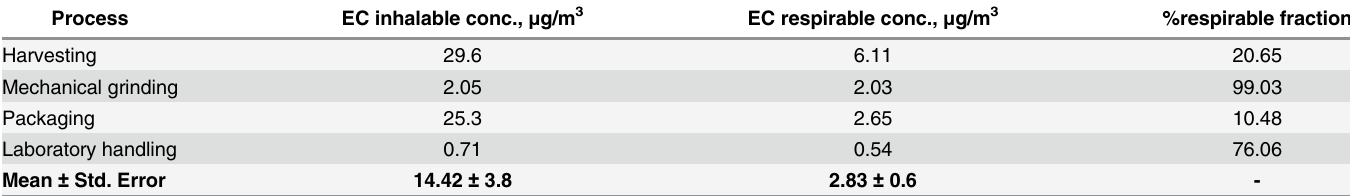
Table 1. Elemental carbon (EC) concentrations found for personal breathing zone (PBZs) samples from workers performing different tasks.